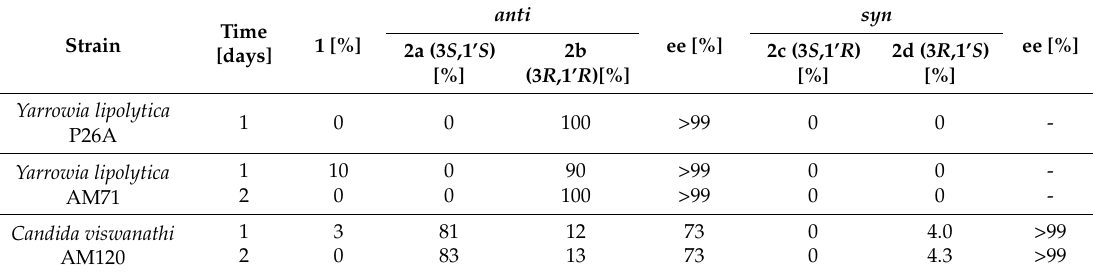
Table 2. The enantioselectivity of biotransformation of α -acetylbutyrolactone 1 (in % according to GC).